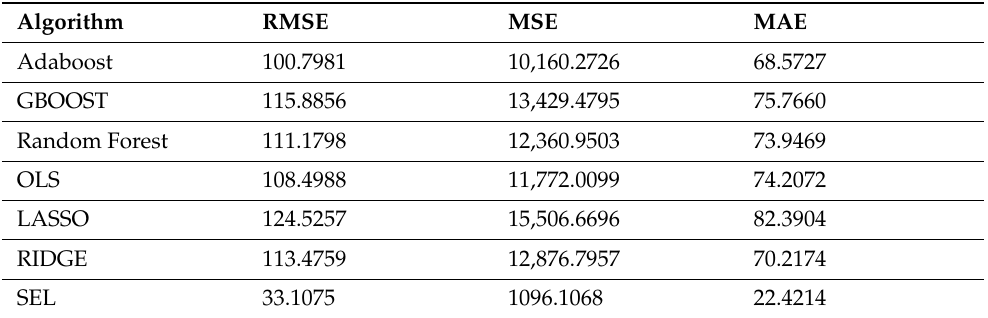
Table 3. Performance Metrics of Machine Learning and Proposed Stacking Ensemble Learning (SEL).